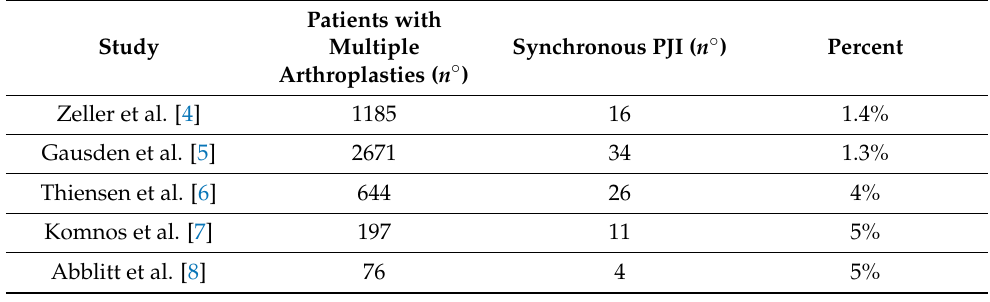
Table 2. Incidence of synchronous PJIs.